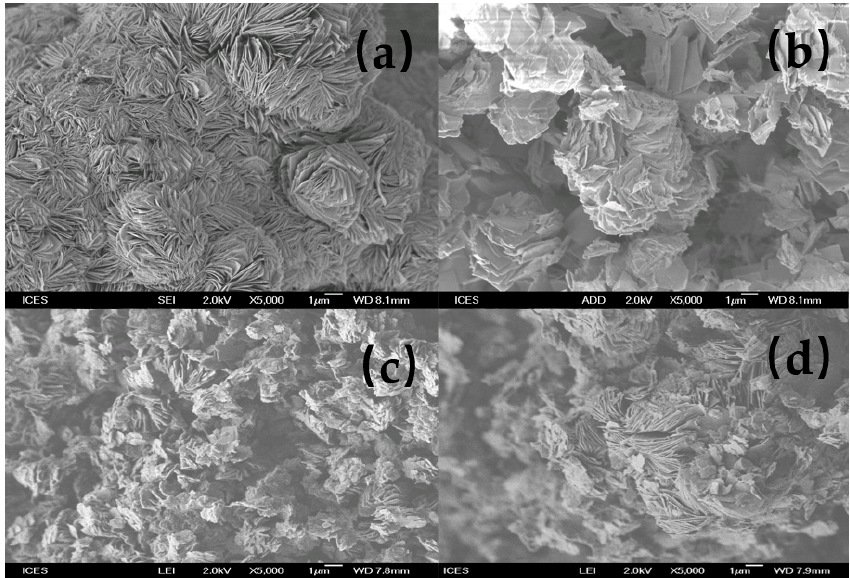
Figure 6. SEM micrographs of ( a ) Na-magadiite treated with different C16TMABr solutions: ( b ) 0.20 mM, ( c ) 0.40 mM, and ( d ) 0.80